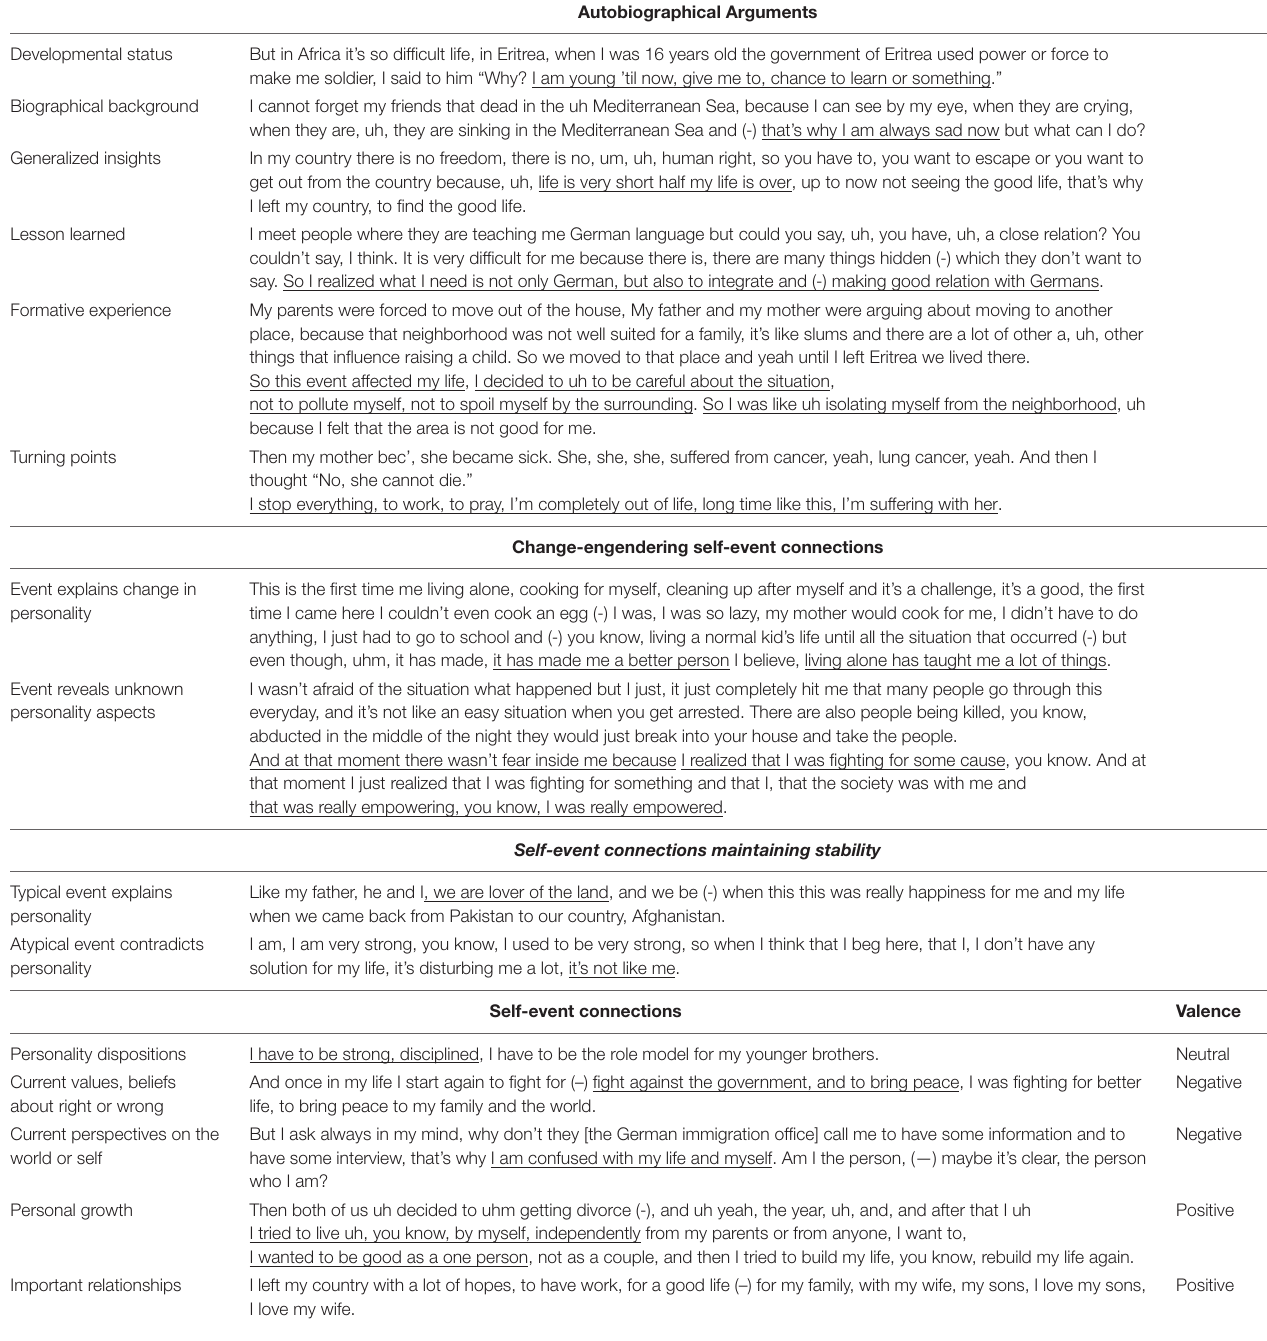
Autobiographical